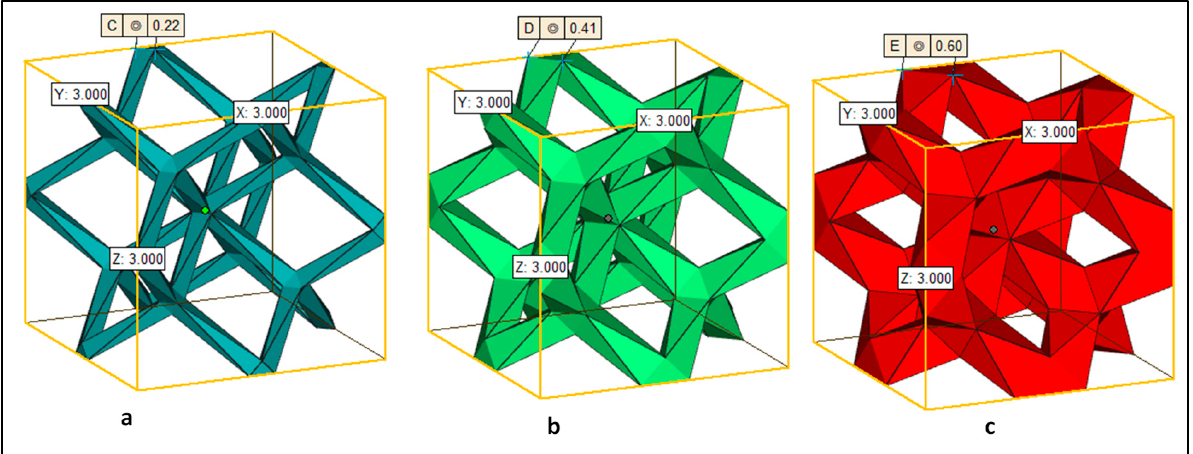
Figure 4. Trabecular structures with unit cell size of 3 mm: ( a ) dode thin with strut size of 0.22 mm, ( b ) dode medium with strut size of 0.41 mm and ( c ) dode thick with strut size of 0.60